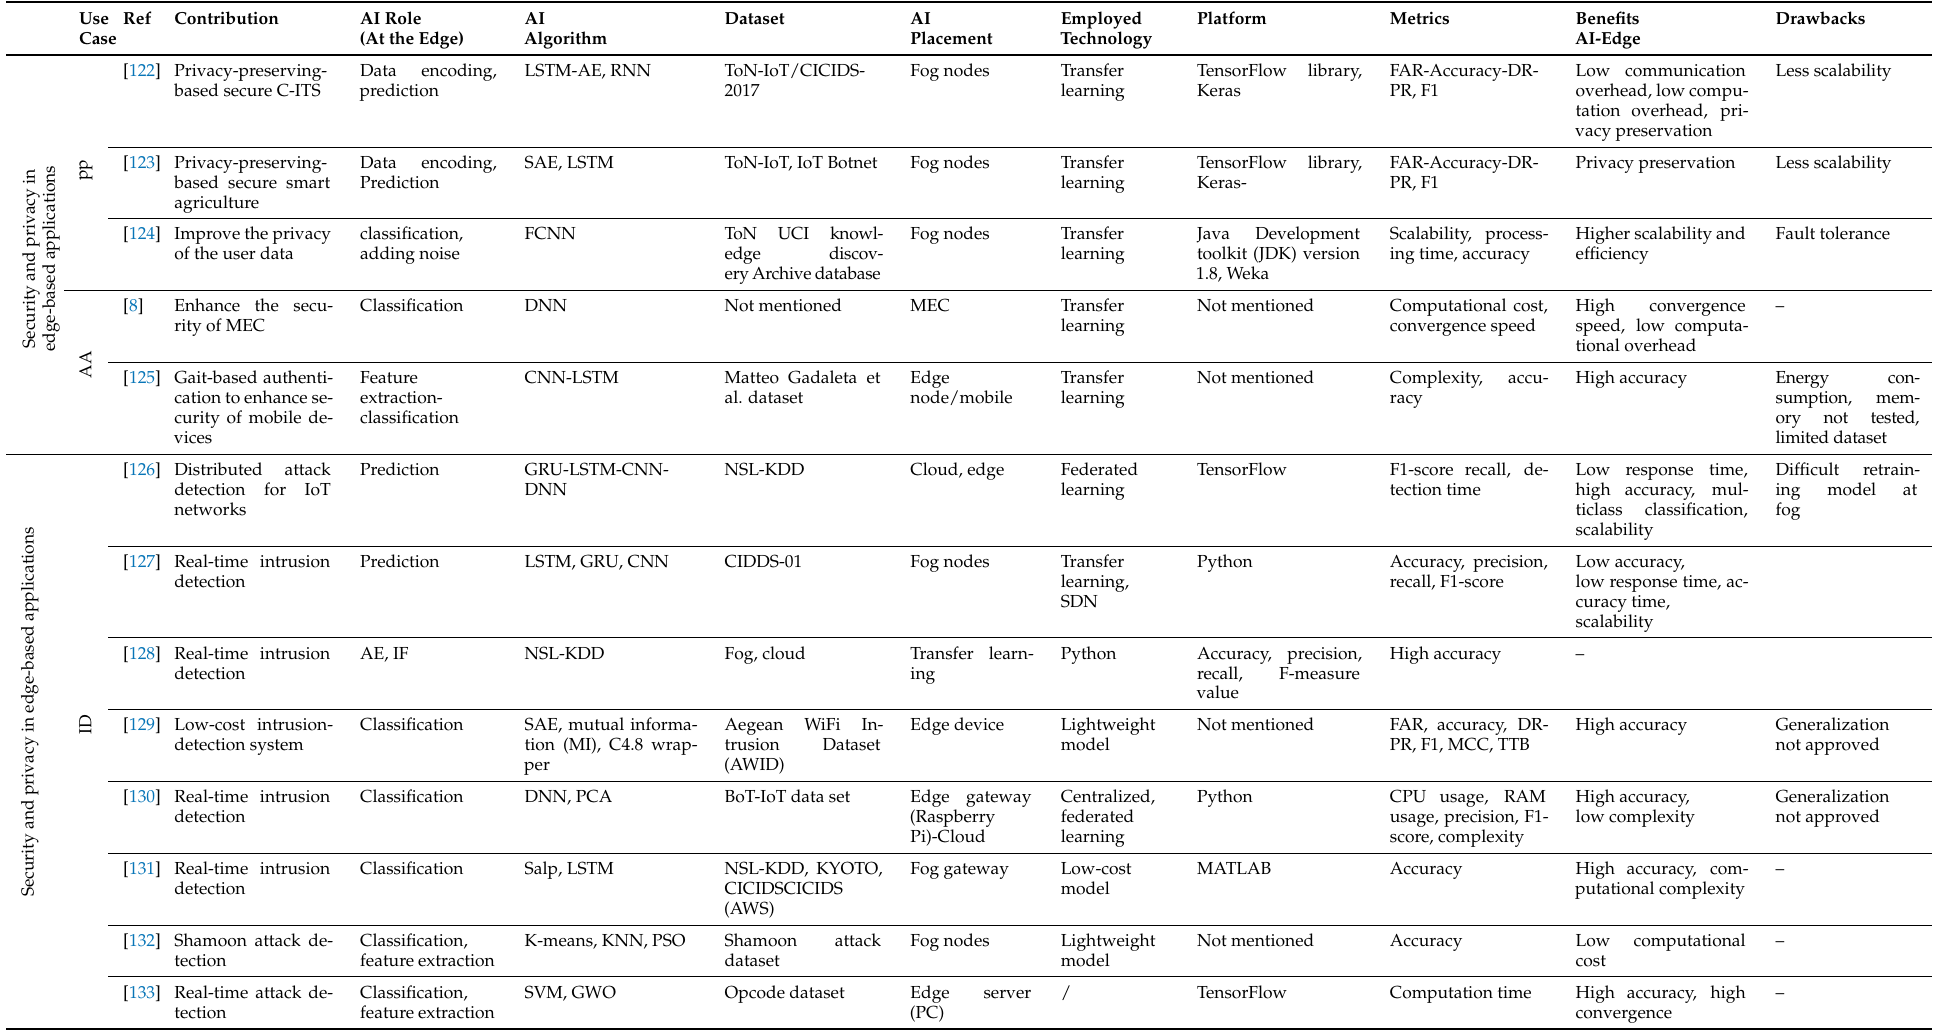
Table 10. Qualitative comparison of security and privacy in edge-based